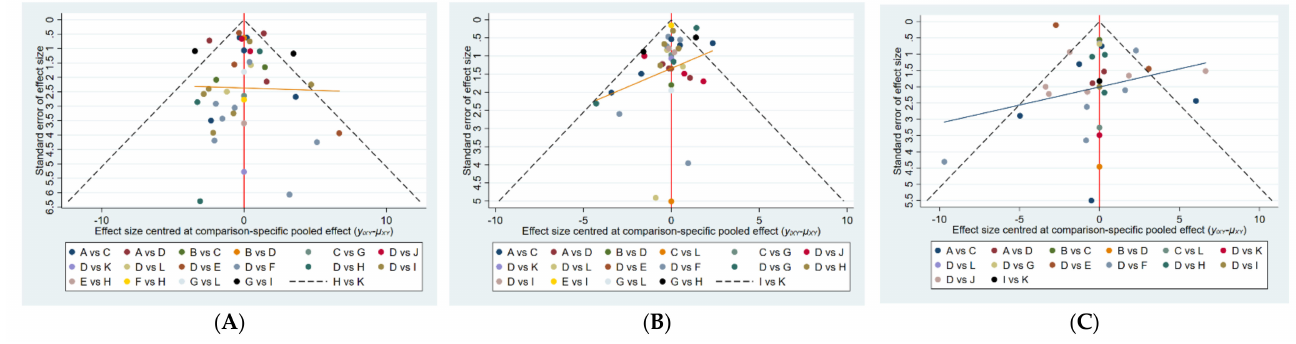
Figure 5. Funnel plot on publication bias. ( A ): UPDRS; ( B ): TUG; ( C ):